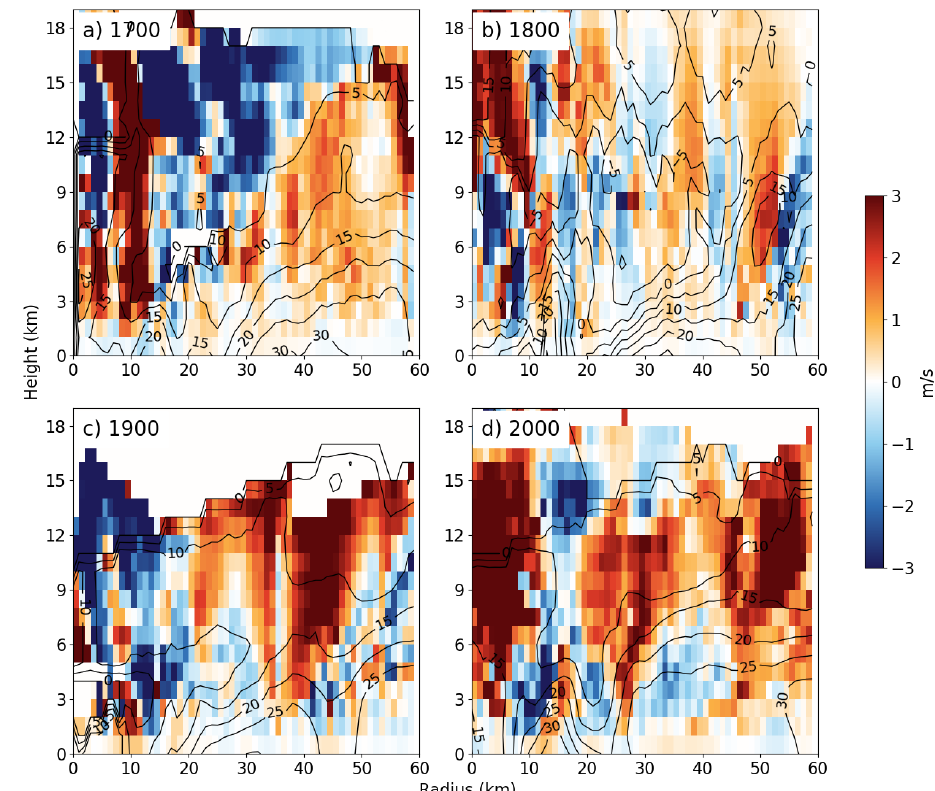
Figure 14. Variations of the vertical velocity (color shading) and reflectivity (black contour) azimuth means in the downwind of stratiform rainband at 190–240° with horizontal radius of 0–60 km outward from typhoon center with altitude at ( a ) 17:00, ( b ) 18:00, ( c ) 19:00 and ( d ) 20:00 UTC. The negative value of vertical velocity azimuth mean represents the downdraft and the positive value the updraft.